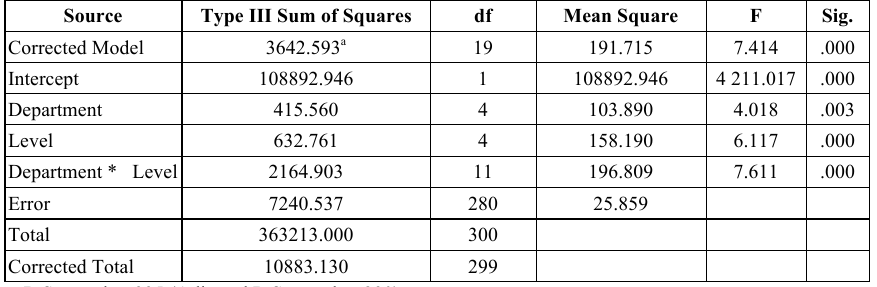
Table 7. Tests of Between-Subjects Effects – Dependent Variable: